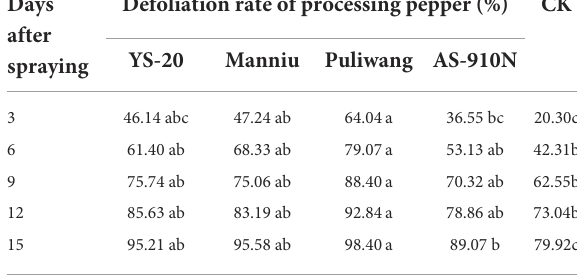
TABLE 4 Effect of aerial spray with adjuvants on the deposition rate sprayed by UAVs. Spraying date